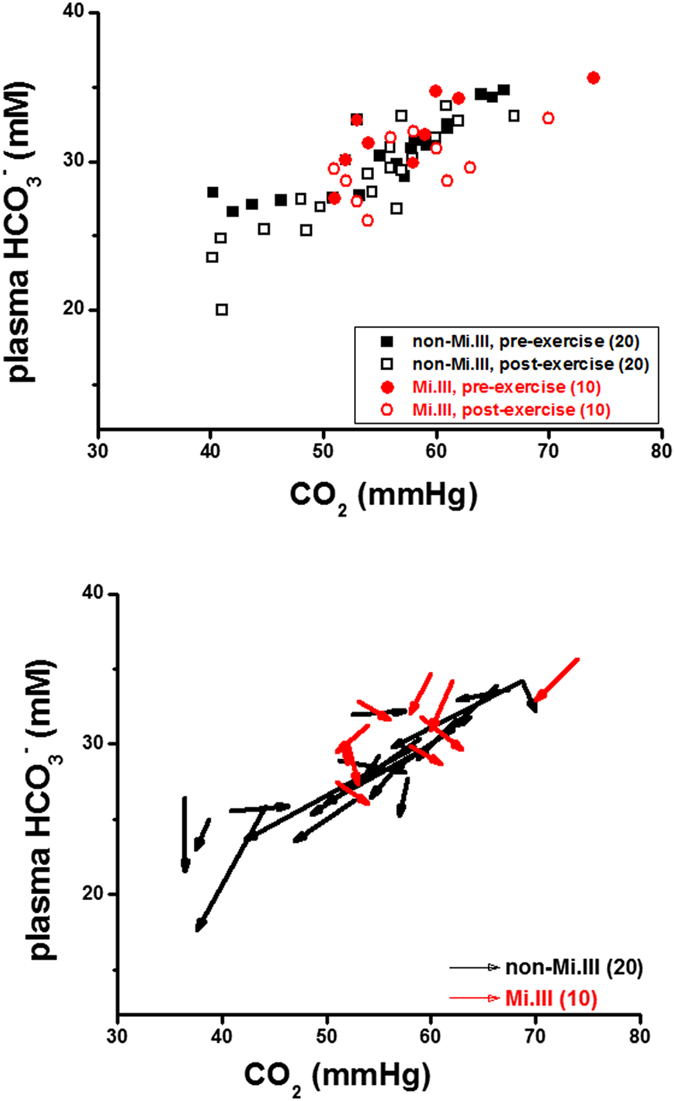
Mi.III and non-Mi.III people exhibited distinguishable blood CO2 responses following the step test.Top: A roughly direct correlation between venous CO2 and HCO3− levels in Mi.III and non-Mi.III subjects alike. The concentrations of venous CO2 and HCO3− immediately before 3-minute step test (shown in solid symbols) and after the test (empty symbols) were plotted for individual Mi.III (red symbols) and non-Mi.III subjects (black). Bottom: To further dissect the changes of venous CO2 and HCO3−, as well as their correlations, for each subject, his pre-exercise and post-exercise data points were connected and represented by a vector. Almost all the subjects, Mi.III and non-Mi.III alike, showed reduced HCO3− levels after exercise. But noticeably, up to 70% of the non-Mi.III subjects had decreased blood CO2 levels after exercise, and only 40% of the Mi.III subjects showed slight decreases of blood CO2 following exercise. 50% of the Mi.III subjects showed slightly higher blood CO2 after exercise. The numbers of the test subjects per group are specified in parentheses.